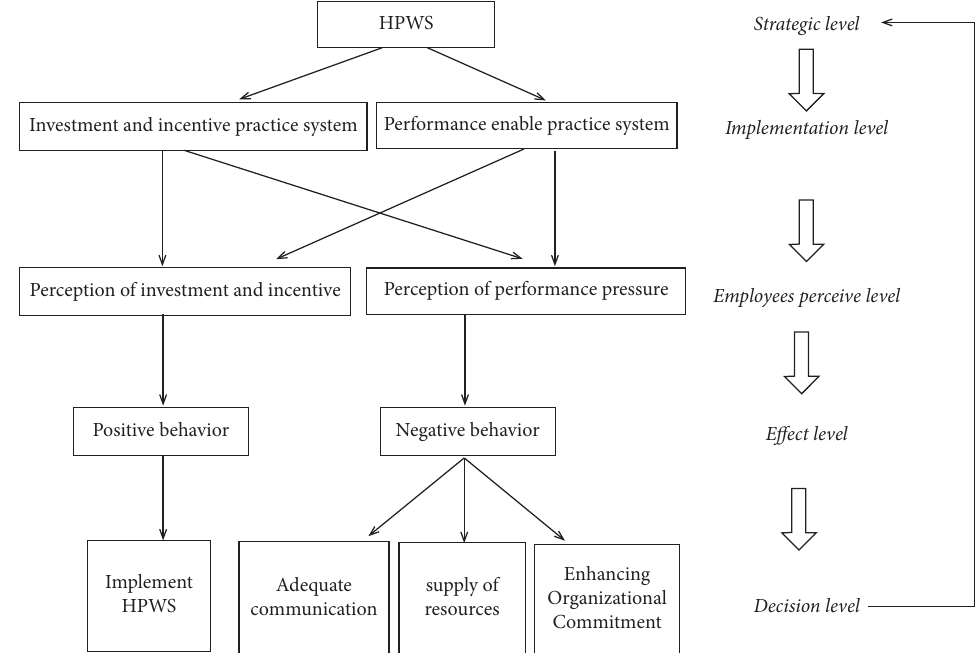
Figure 4: Five-level HPWS